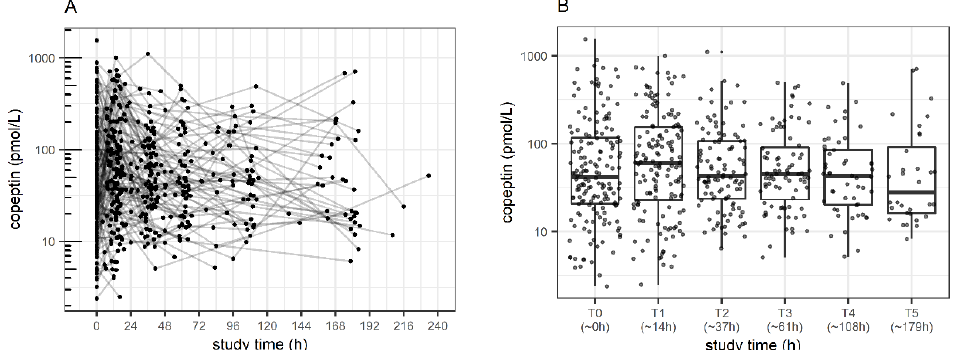
Figure 1. Blood copeptin levels over the study period of 168 h in critically ill children: ( A ) copeptin concentrations with individual trajectories over time; ( B ) blood copeptin concentrations over time presented as box plots. Boxes show the interquartile range (IQR). Solid lines are the median, 25th and 75th quantile, and whiskers equal to 25th quantile − 1.5 IQR and 75th quantile +1.5 IQR. Corre- sponding time points: T0 = study start/ T1 = 14 h (median, interquartile range (11, 16 h)); T2 = 37 h (34, 40); T3 = 61 h (58, 63); T4 = 108 h (97, 110); T5 = 179 h (168, 182).